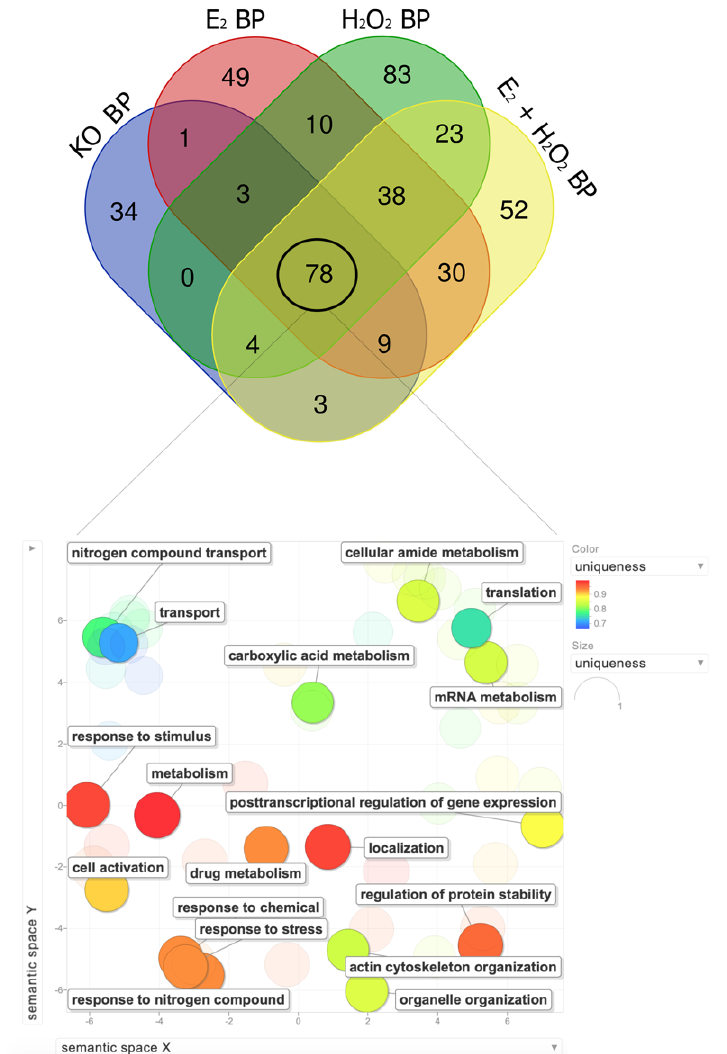
Figure 5. Eulero–Venn analysis of the BPs identified in the four analyzed conditions with a focus on the common BPs. The Eulero–Venn analysis returned 78 BP that were common to all the conditions. At the bottom of the figure, the significant non-redundant BPs are shown. The color grade of the BPs refers to the semantic uniqueness of the terms, ranging from blue (uniqueness = 0.7) to red (uniqueness = 1).